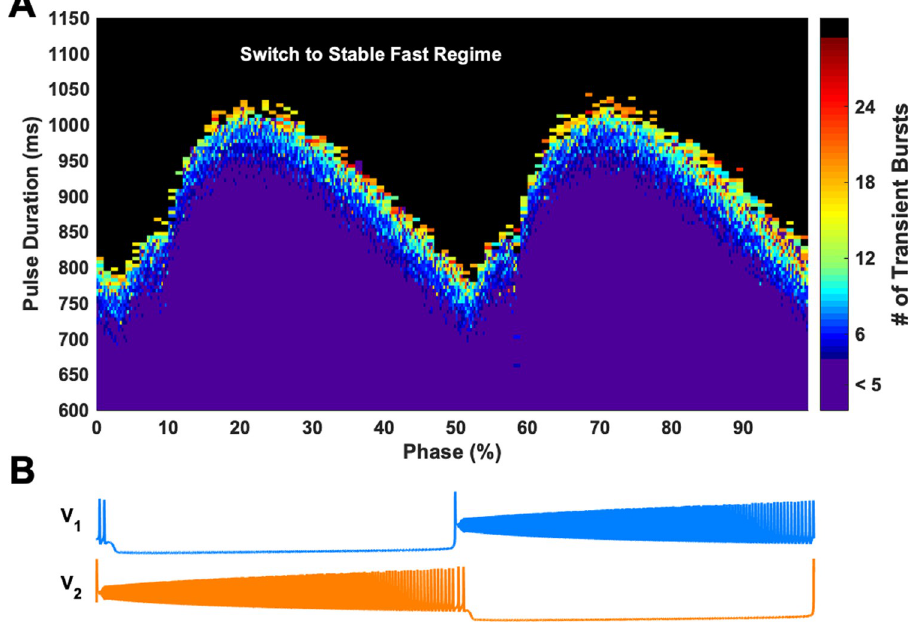
Fig 2. The number of bursts contained in a transient response depends on the phase of pulse onset and pulse duration. The color map represents the duration of transient fast rhythm response (measured as the number of transient bursts). The black region above the colored portion represents traces where the pulse caused a switch to the stable fast rhythm. The locomotor-like cycle corresponding to the phase of pulse onset during the slow rhythm is shown at the bottom by one full bursting cycle period of neurons #1 (blue trace) and #2 (orange trace).